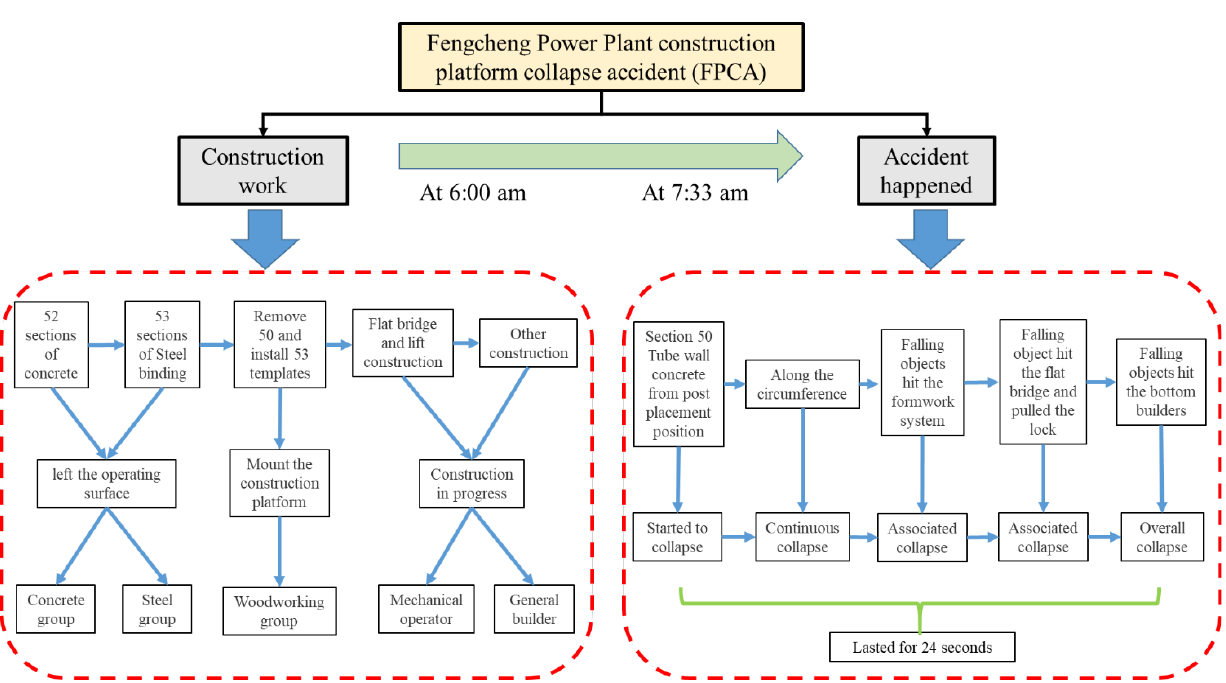
Figure 3. Overview of the